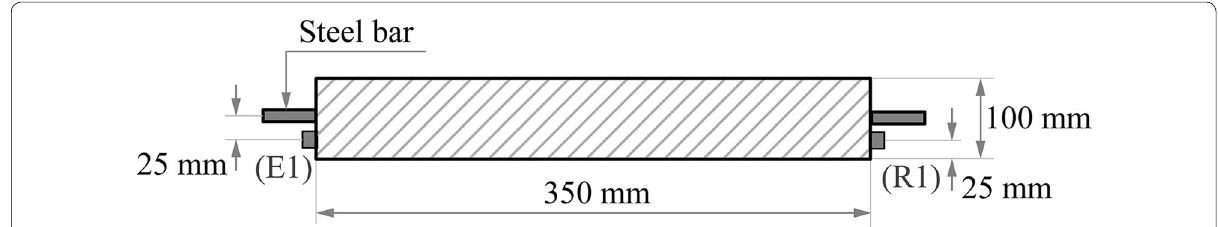
Fig. 5 Positions of the transducers. E1: emitter. R1: receiver.